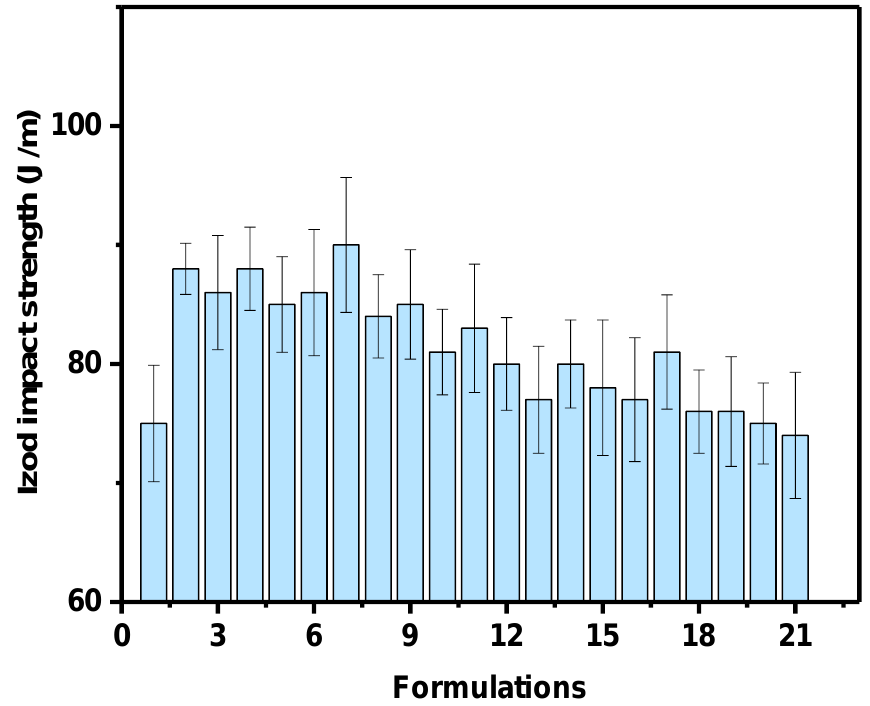
Figure 5. Izod impact strength (J/m) of the HDPE/filler composites.